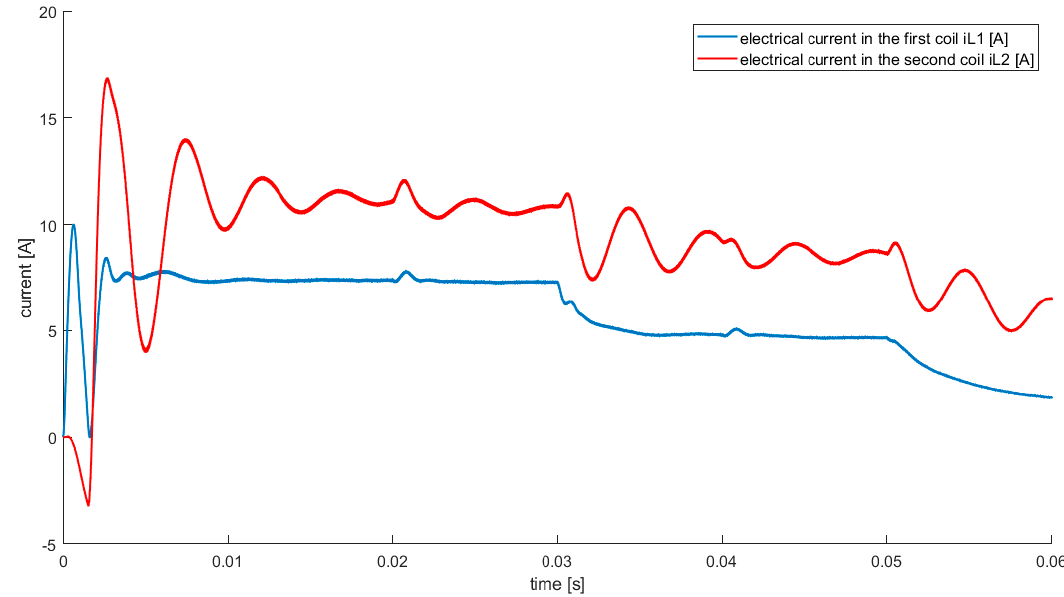
Figure 12. Evolution of PV current over time.